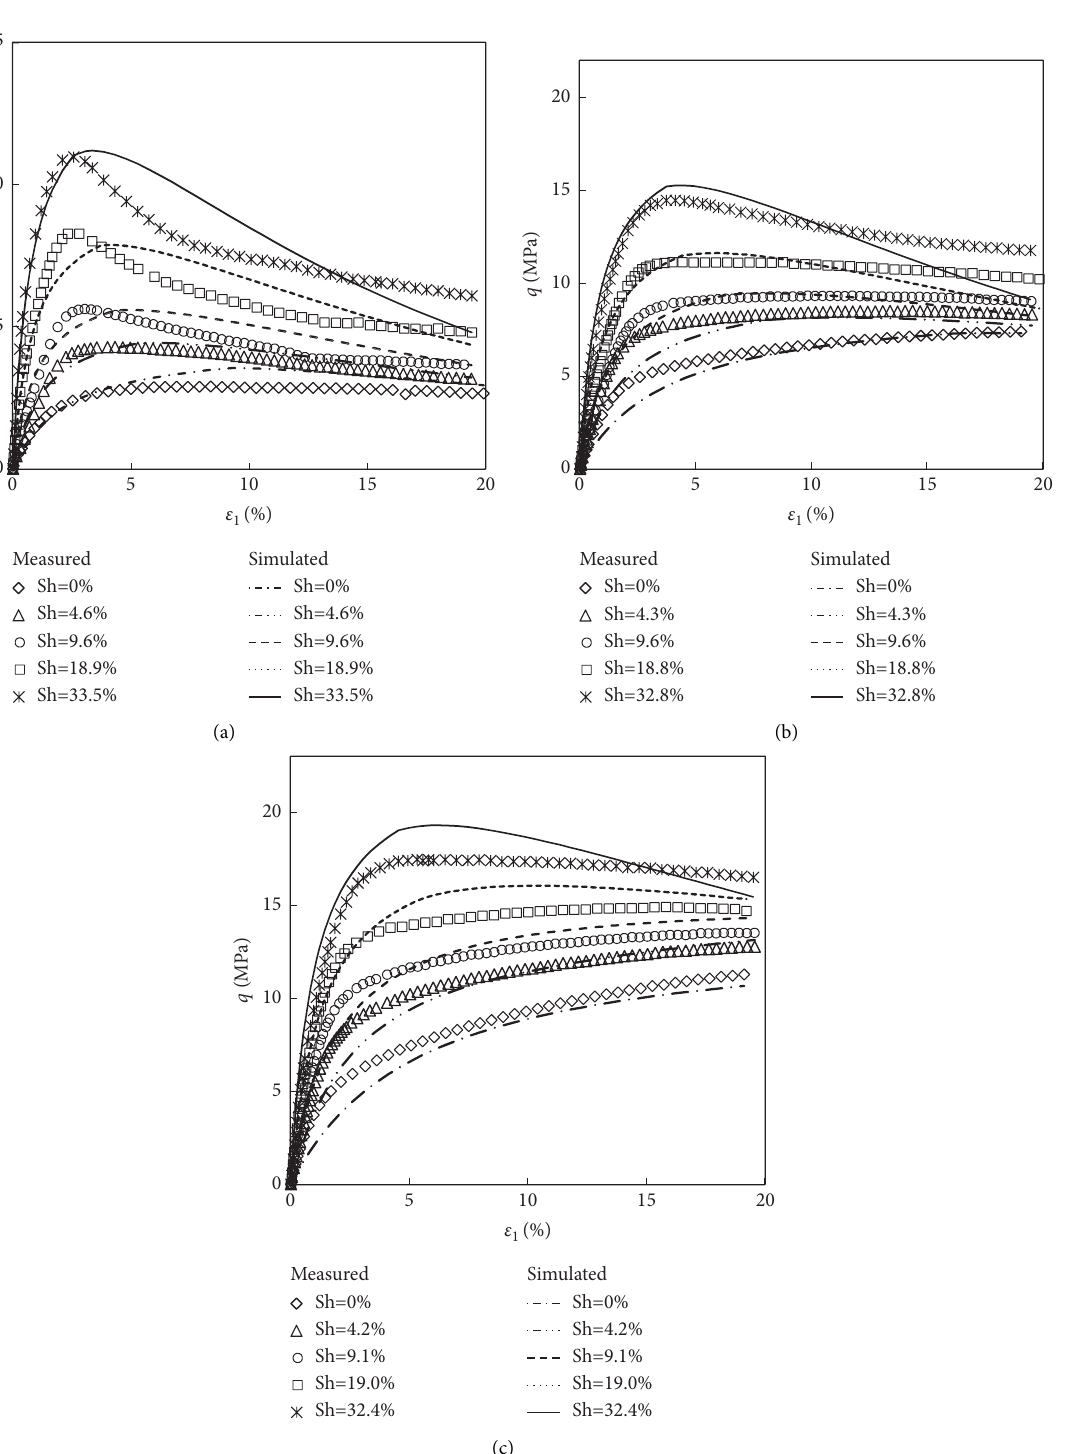
′ � 1MPa, (b) σ ′ � 3MPa, and (c) σ 3 3